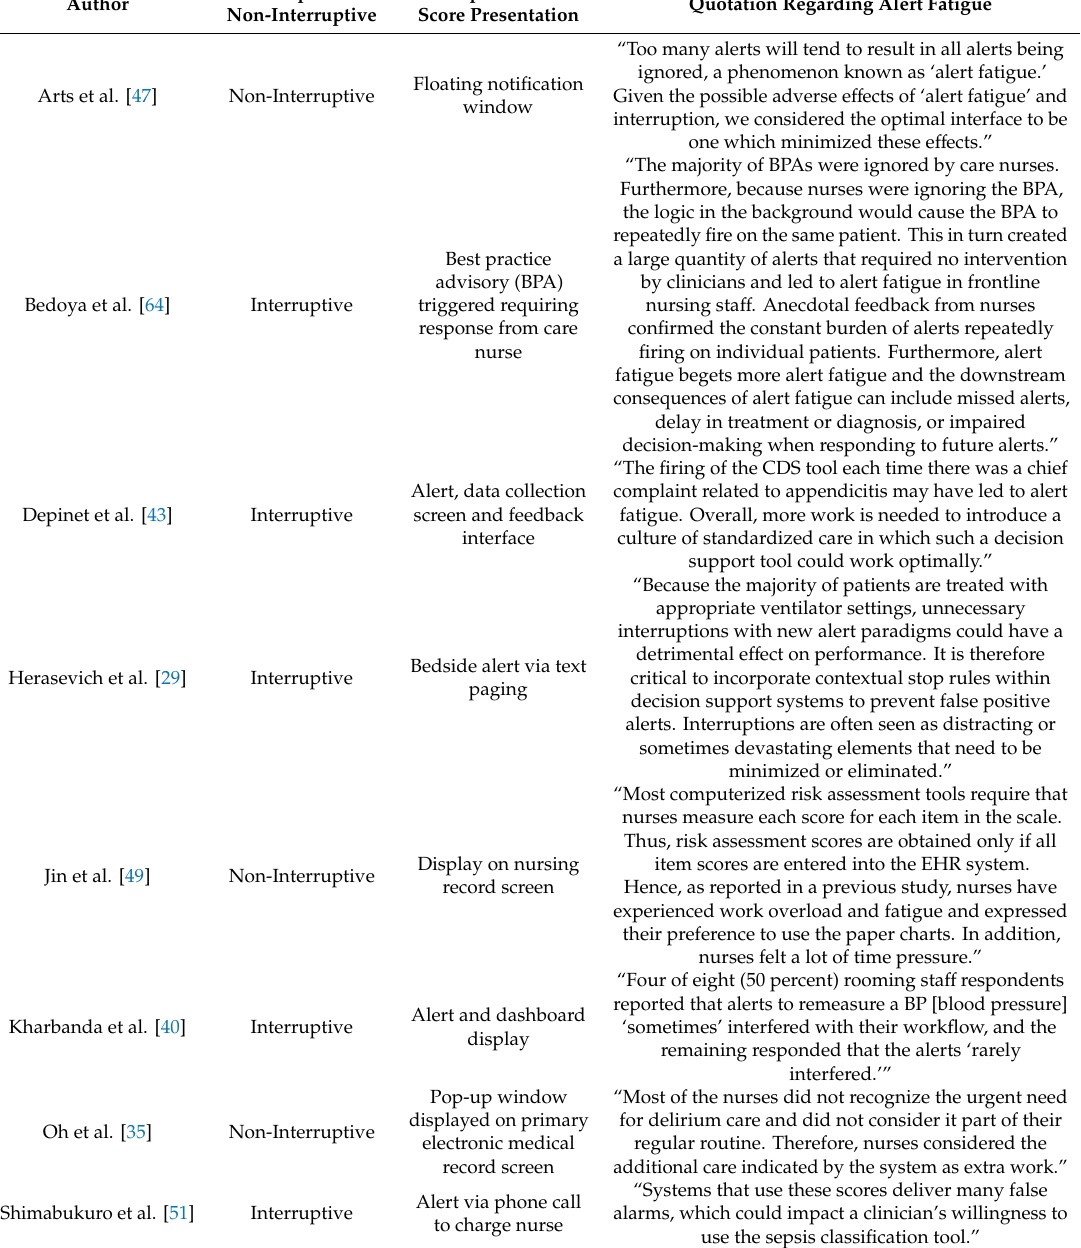
Table 2. Classification and method of risk score presentation of studies that discussed alert fatigue in relation to implementation of predictive models within electronic health record